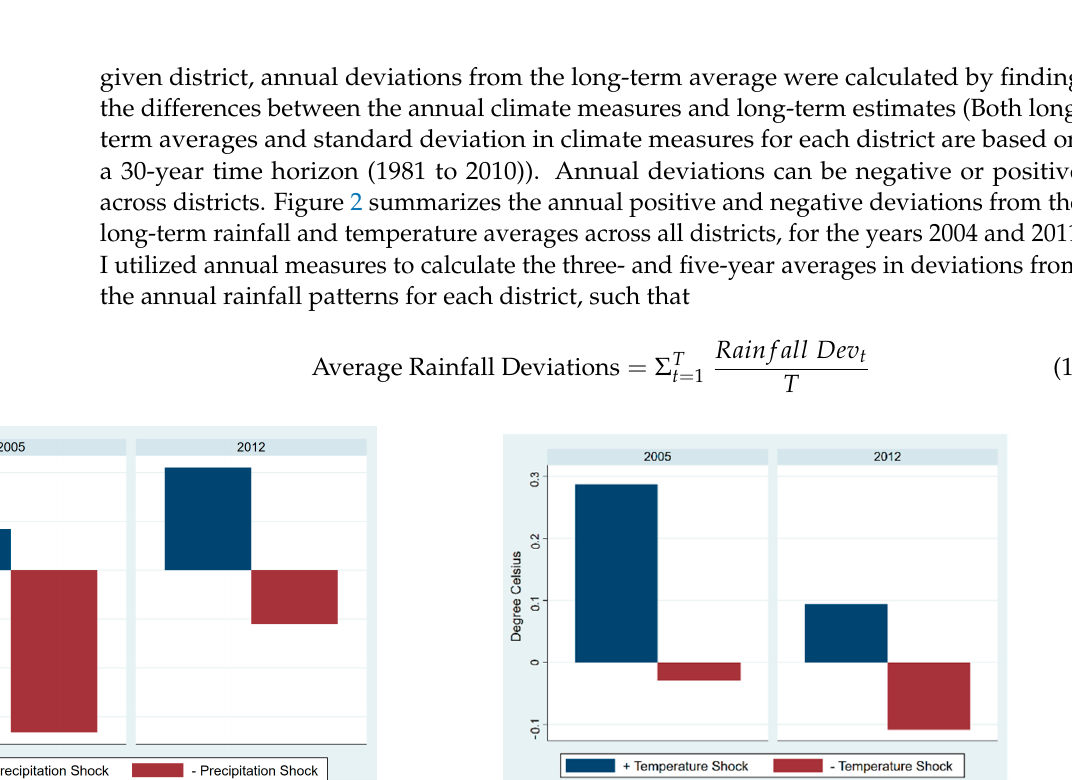
Figure 1. Average annual long-term climate patterns, by districts, in India (1981 to 2010). Left: The average annual long-term rainfall levels of all districts in India (1981 to 2010). Right: The average annual long-term temperature levels of all districts in India (1981 to 2010).